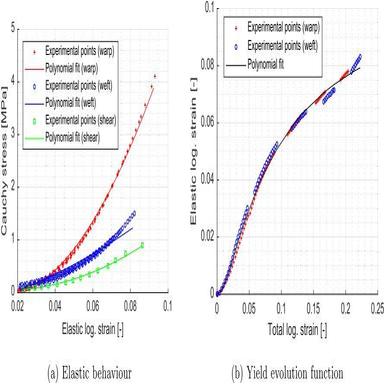
Polynomial fits used to build the constitutive model: (a) polynomial functions used to derive 6 stiffness constants E0 1, E1 1, E0 2, E1 2, G0 12 and G1 12, in warp, weft and shear directions respectively; (b) polynomial function relating the part of elastic strain as a function of total strain: ϵel = f(ϵ).